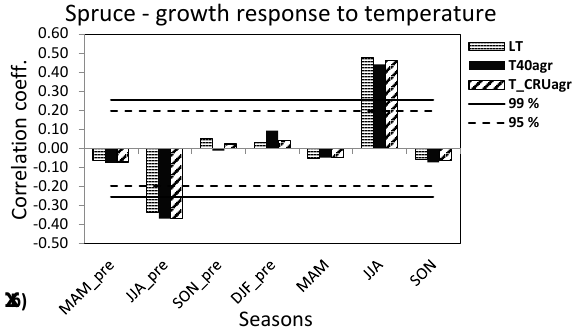
greater spatial variability of precipitation variable compared to